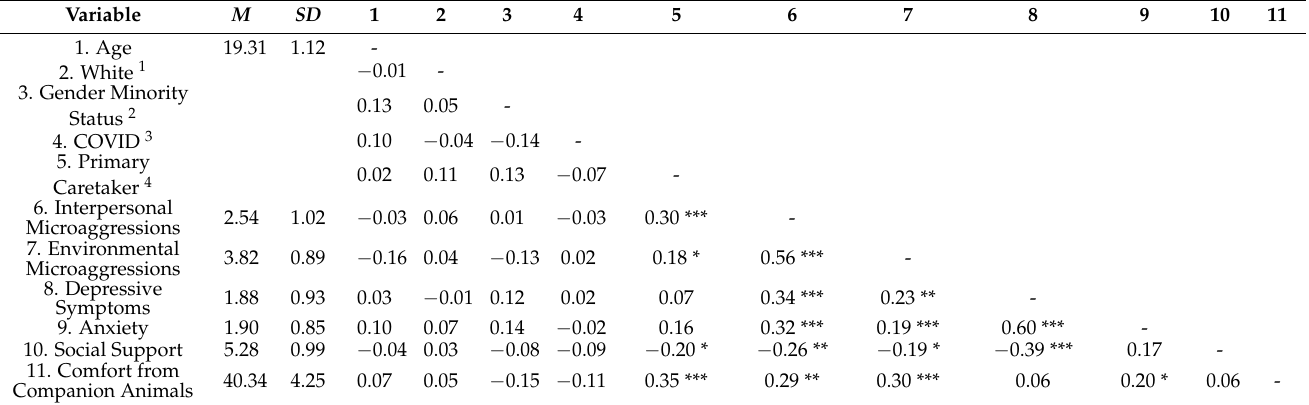
Table 2. Intercorrelations, unstandardized means, and standard deviations ( SD ) for constructs of interest ( n =